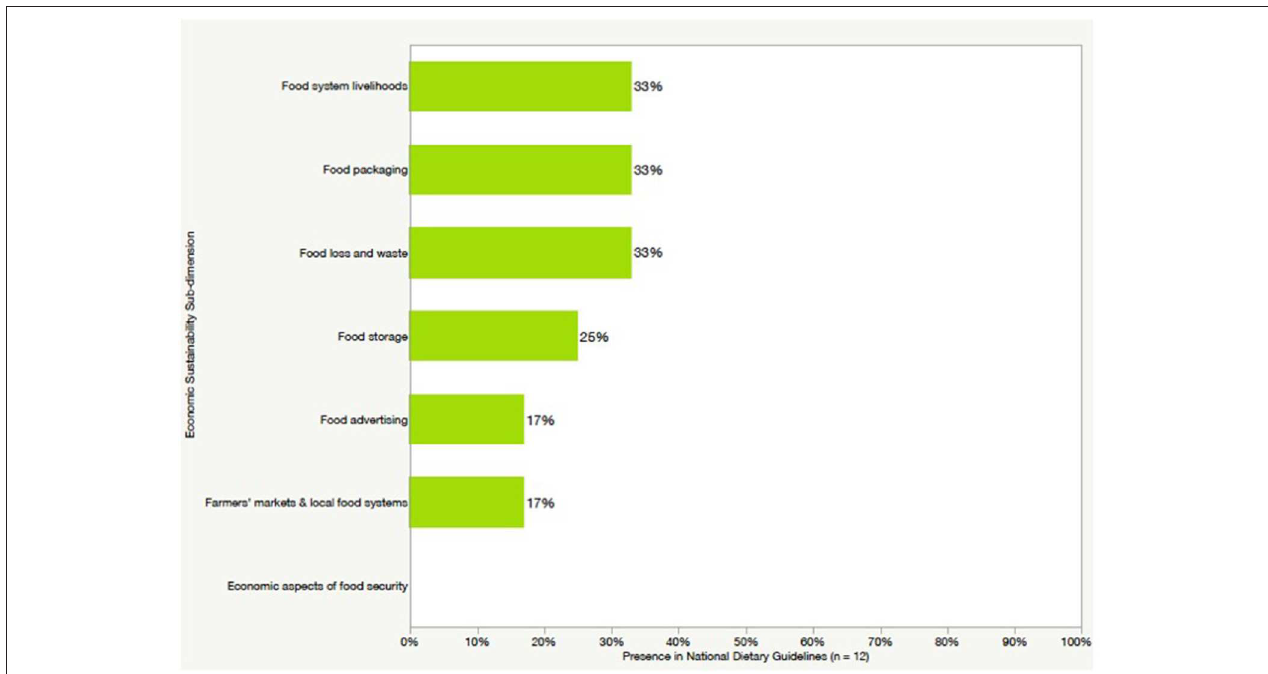
FIGURE 4 | Presence of human health sub-dimensions in national dietary guidelines. This figure demonstrates the presence of the eight sub-dimensions of human health sustainability in the 12 national dietary guidelines evaluated in this study.